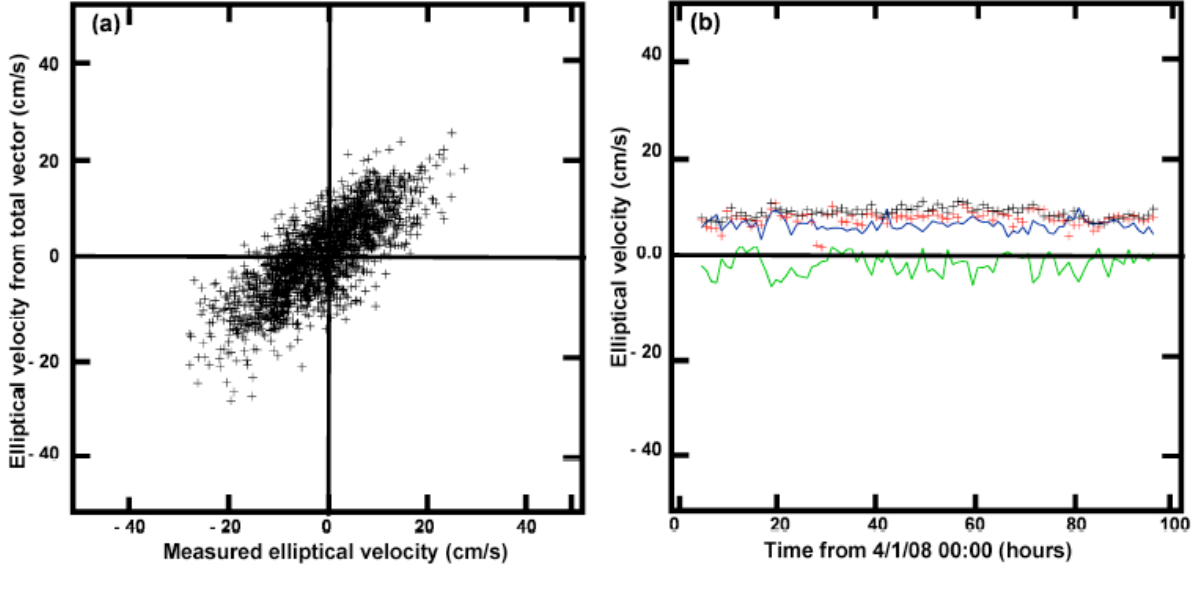
Figure 20. (a) Scatter plot of elliptical velocity data points: Elliptical velocity from COMM/FORT totals vs. COMM elliptical velocity; (b) Comparison statistics averaged over the map, plotted vs. time: Blue—standard deviation between COMM ellipticals and ellipticals from COMM/FORT total velocities. Green—bias. Red—spatial standard deviation in COMM